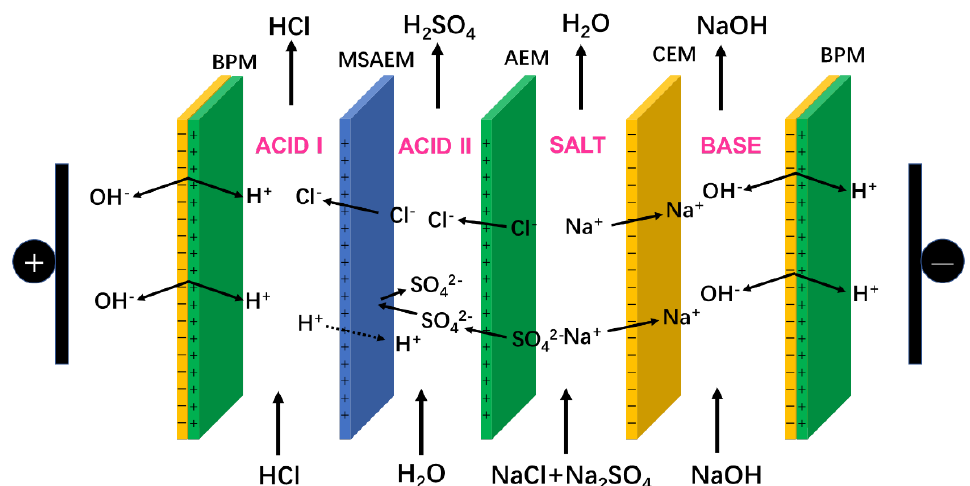
Figure 2. Schematic diagram for the novel electrodialysis stack (SBMED) process. BPM, bipolar membrane; AEM, anion-exchange membrane; CEM, cation-exchange membrane; MSAEM, mono-selective anion-exchange membrane.